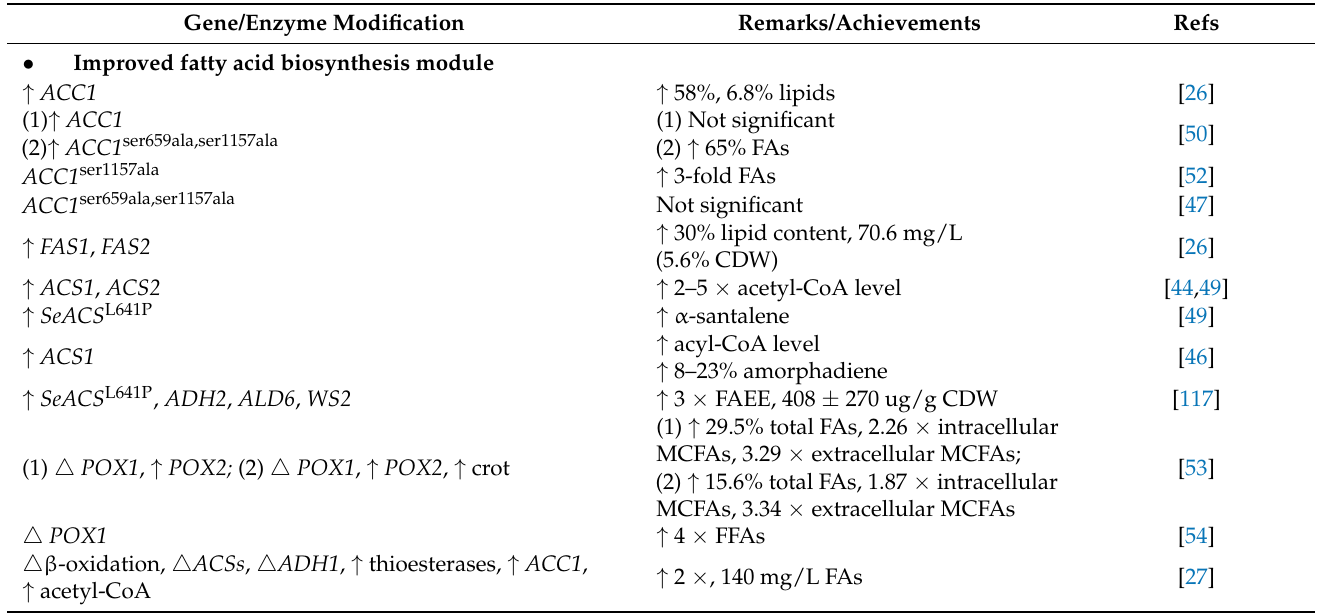
Table 2. Metabolic engineering strategies of yeast S. cerevisiae for improved lipid